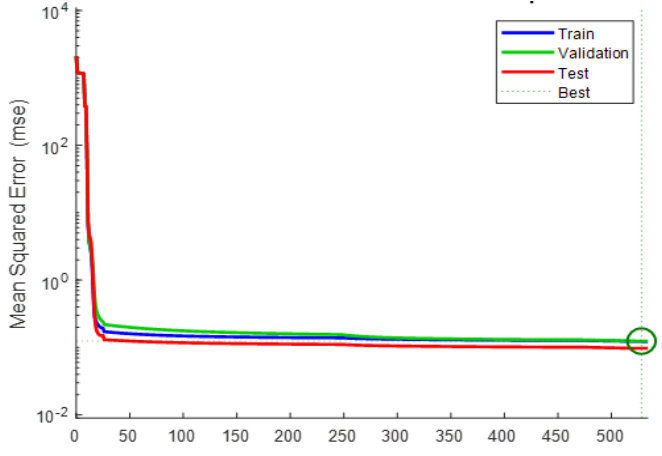
Figure 8. Best validation performance plot.